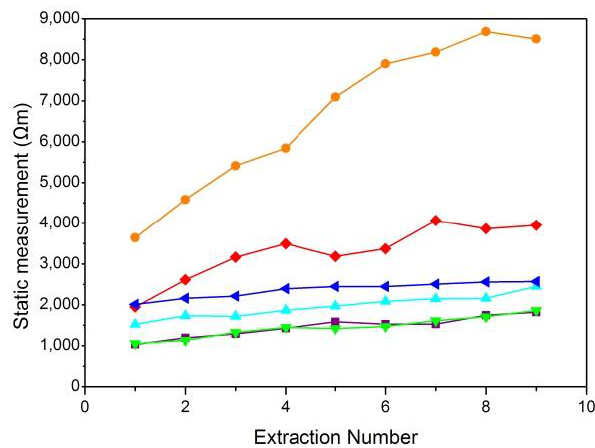
Figure 5. Results of six static skin resistance measurements. The time interval between each two measurement results was over 10 min.